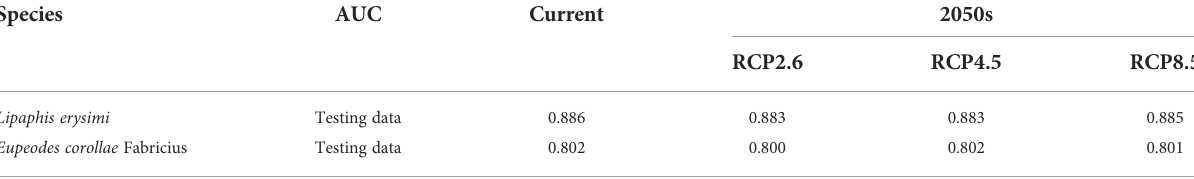
TABLE 2 Area under the receiver operating characteristic